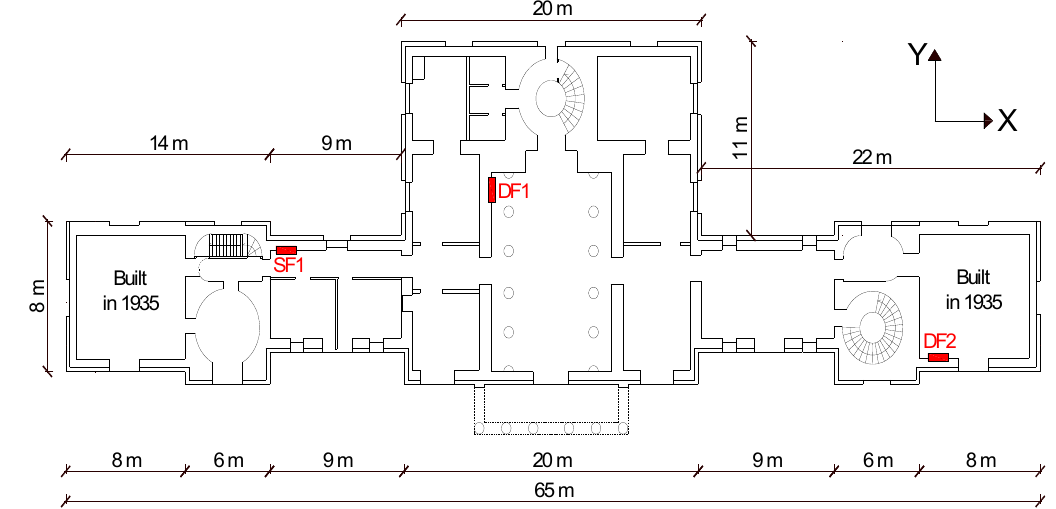
Figure 2. Plan layout of the ground floor.